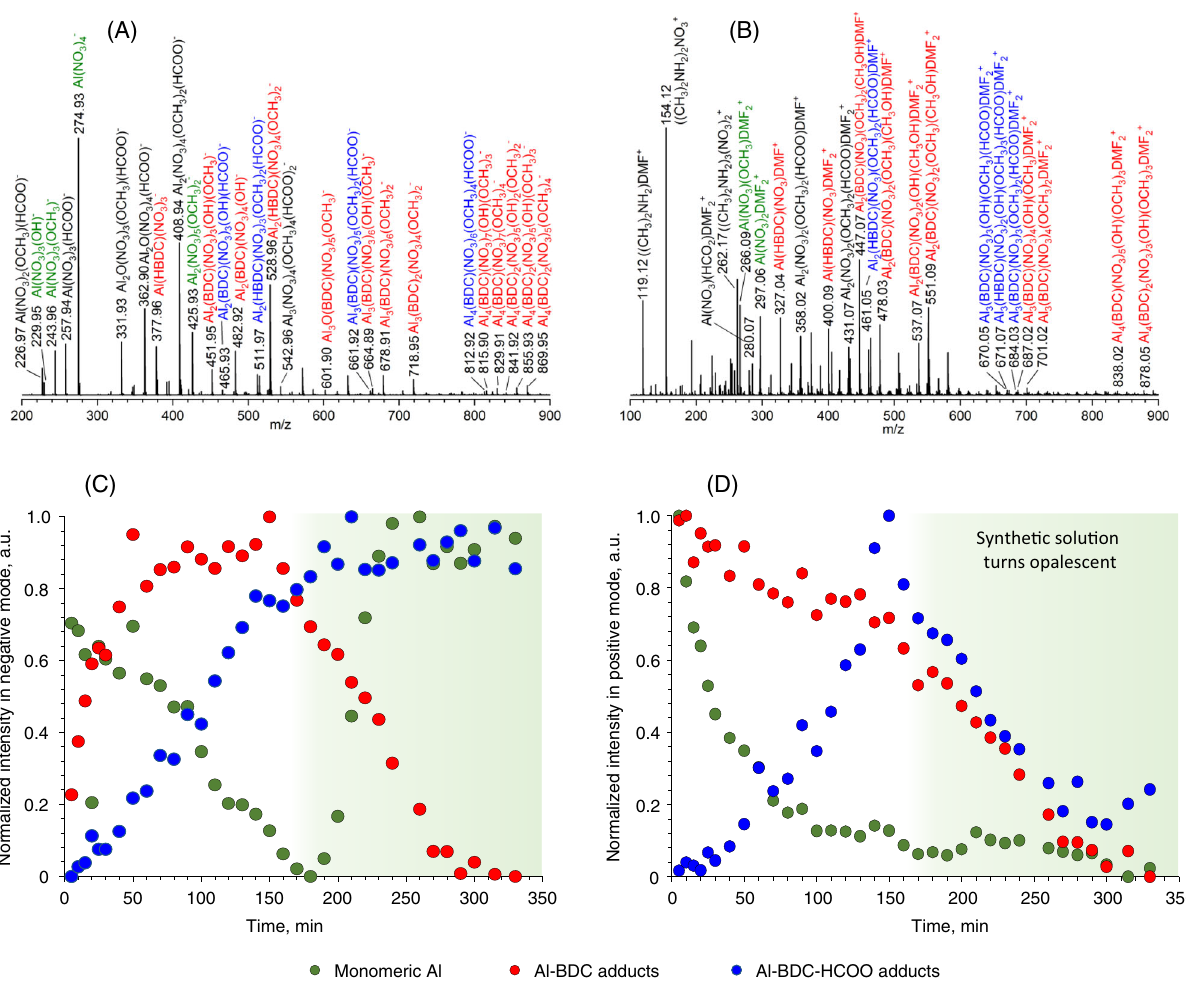
Fig. 1 ESI Q-TOF mass spectrometry data. Mass spectra of the synthetic mixture after 100 min measured in ( A ) negative and ( B ) positive modes, respectively; time-resolved evolution of the MS signals attributed to monomeric aluminum, aluminum-terephthalate adducts and aluminum-terephthalate- formate adducts in ( C ) negative and ( D ) positive modes. The reaction was carried out at 343 K, the samples were diluted with methanol (1:100 v/v) prior to injection to mass spectrometer, leading to appearance of methoxy ligands in some of MS peaks. Complete description of the spectra together with the peak assignment is given in Tables S1,